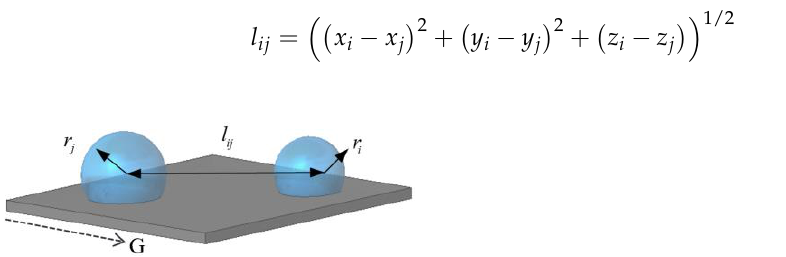
Figure 3. Schematic diagram of droplet coalescence judgment.